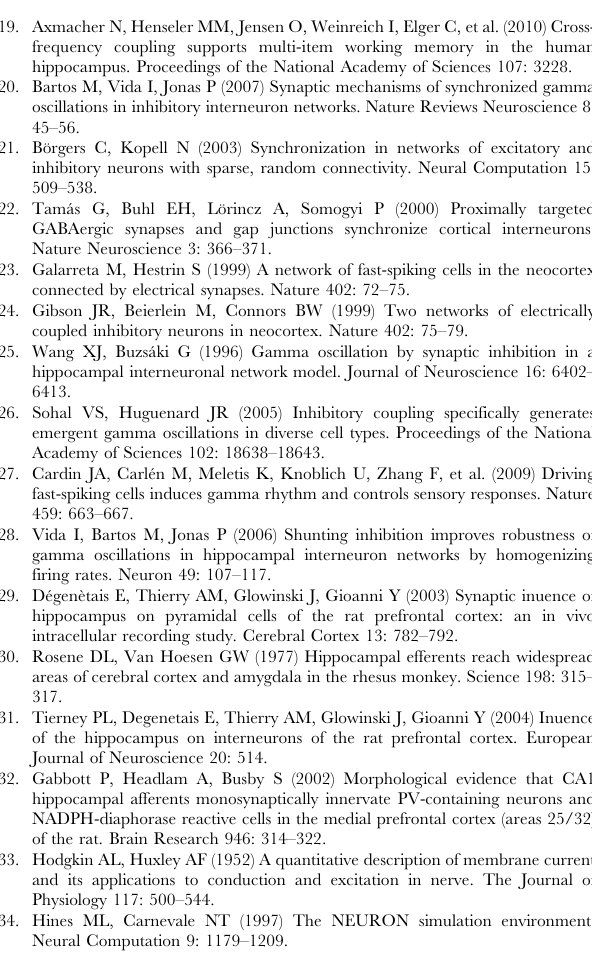
Figure S1 Distributions of theta phase/gamma ampli- tude values for different frequencies of the theta signal provided as input to the model network. Figure S2 Norm of the mean of the composite phase/ amplitude distributions, as a function of theta frequen- cy. Figure S3 Norm of the mean of the composite phase/ amplitude distributions, as a function of theta input amplitude, when only the pyramidal cells receive theta- modulated input. The dotted line represents the value of this